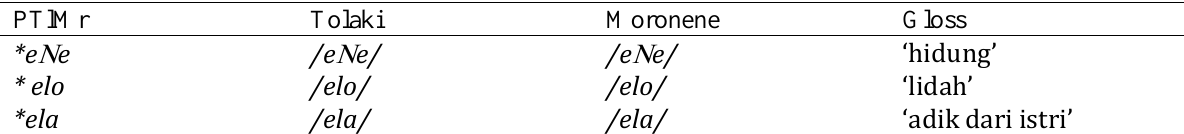
Table 11. The iinitial position of the word PTlMr Tolaki Moronene